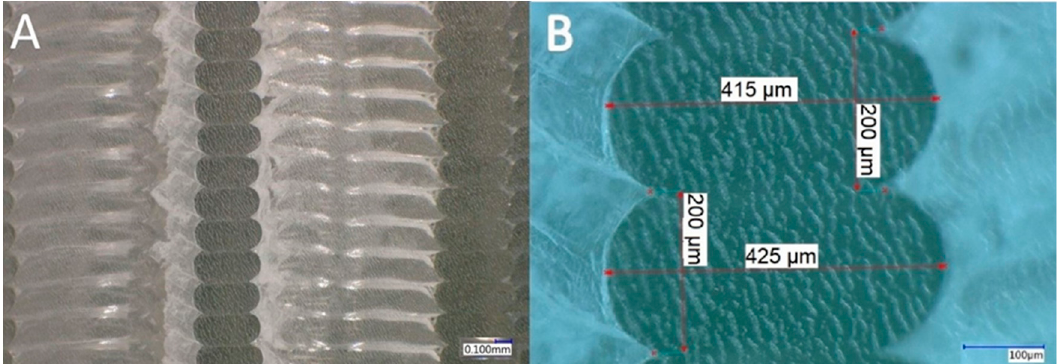
Figure 12. Microscopic cross-section image of 3D-printed sample with 1.6 ILD before compression test (cyclic loading–unloading). ( A ) 100× magnification setting, ( B ) 500× magnification setting.